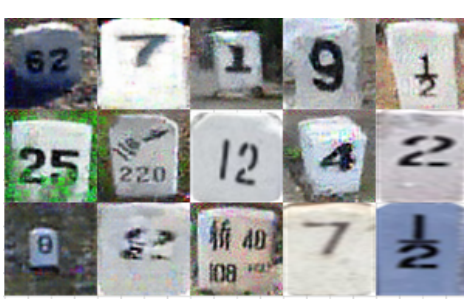
Figure 3. The kilometer posts generated by the DCGAN model.